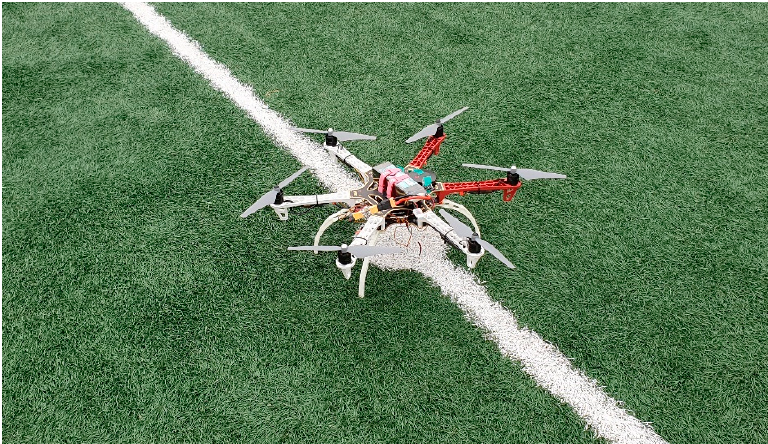
Figure 3. Unmanned aerial vehicle (UAV).